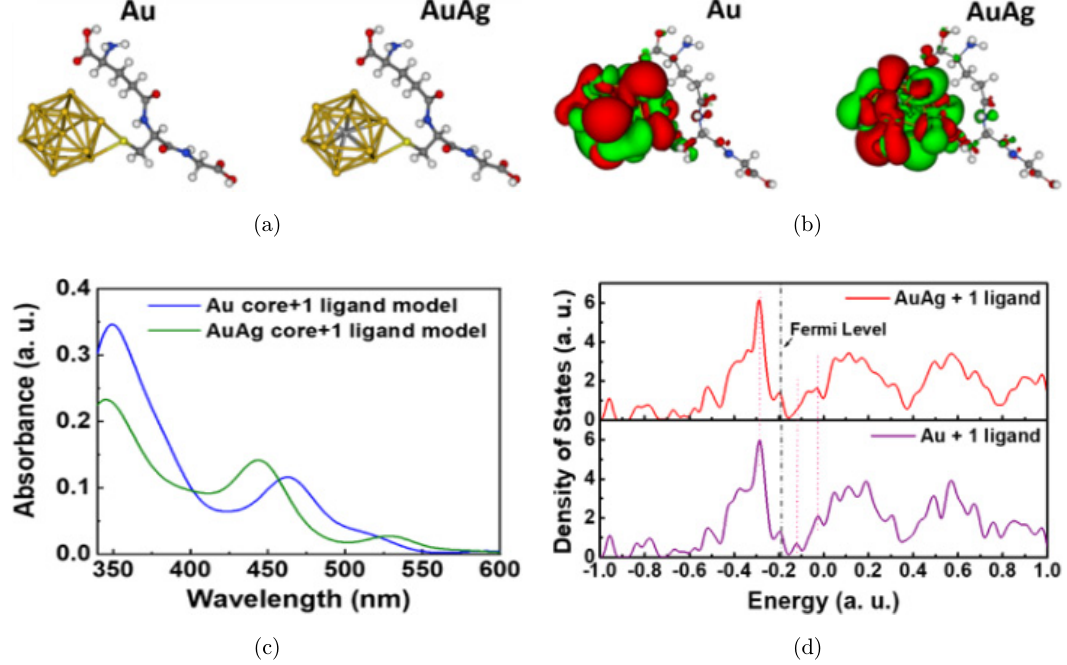
Fig. 5. TDDFT simulation of one metal core connects with single ligand, (a) two simpli¯ed model after optimized. (b) Density – density responds for Au (AuAg) model which excited at 349.5 nm (345.5 nm). Color codes: green for electrons (density excess) and red for holes (density de¯ciency). (c) The simulation absorption spectra with peaks at 349.5/462.5 nm (13 atoms Au core) and 345.5/444 nm (12 þ 1 mixed core), a blue-shift appeared and (d) DOS analyzed by Kohn-Sham energy with broadening factor of 0.05 atomic unit.